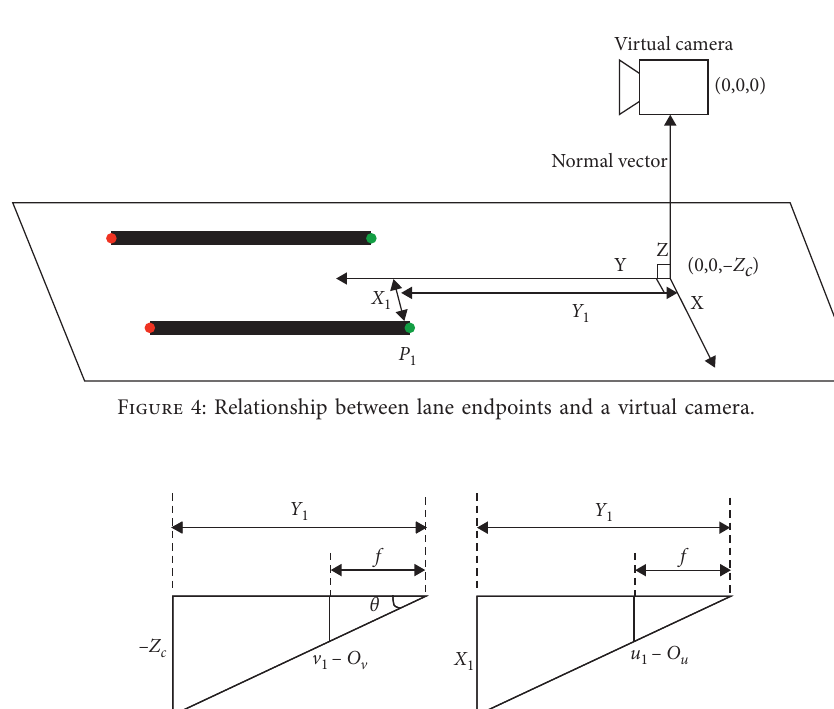
; (b) similarity in triangles for X . 1 1